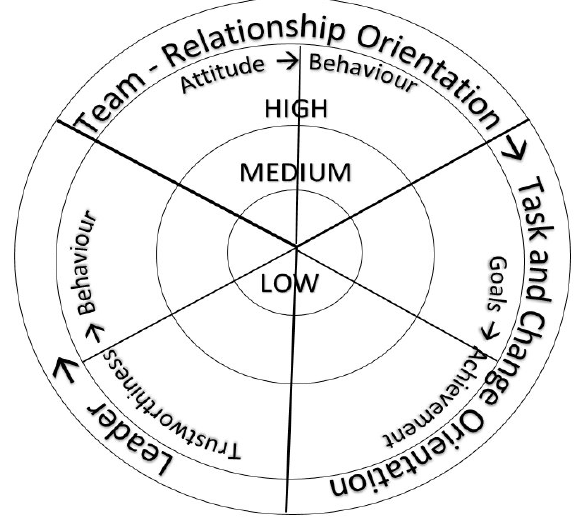
Fig. 2. LIC Model “Leaders’ impact on culture”